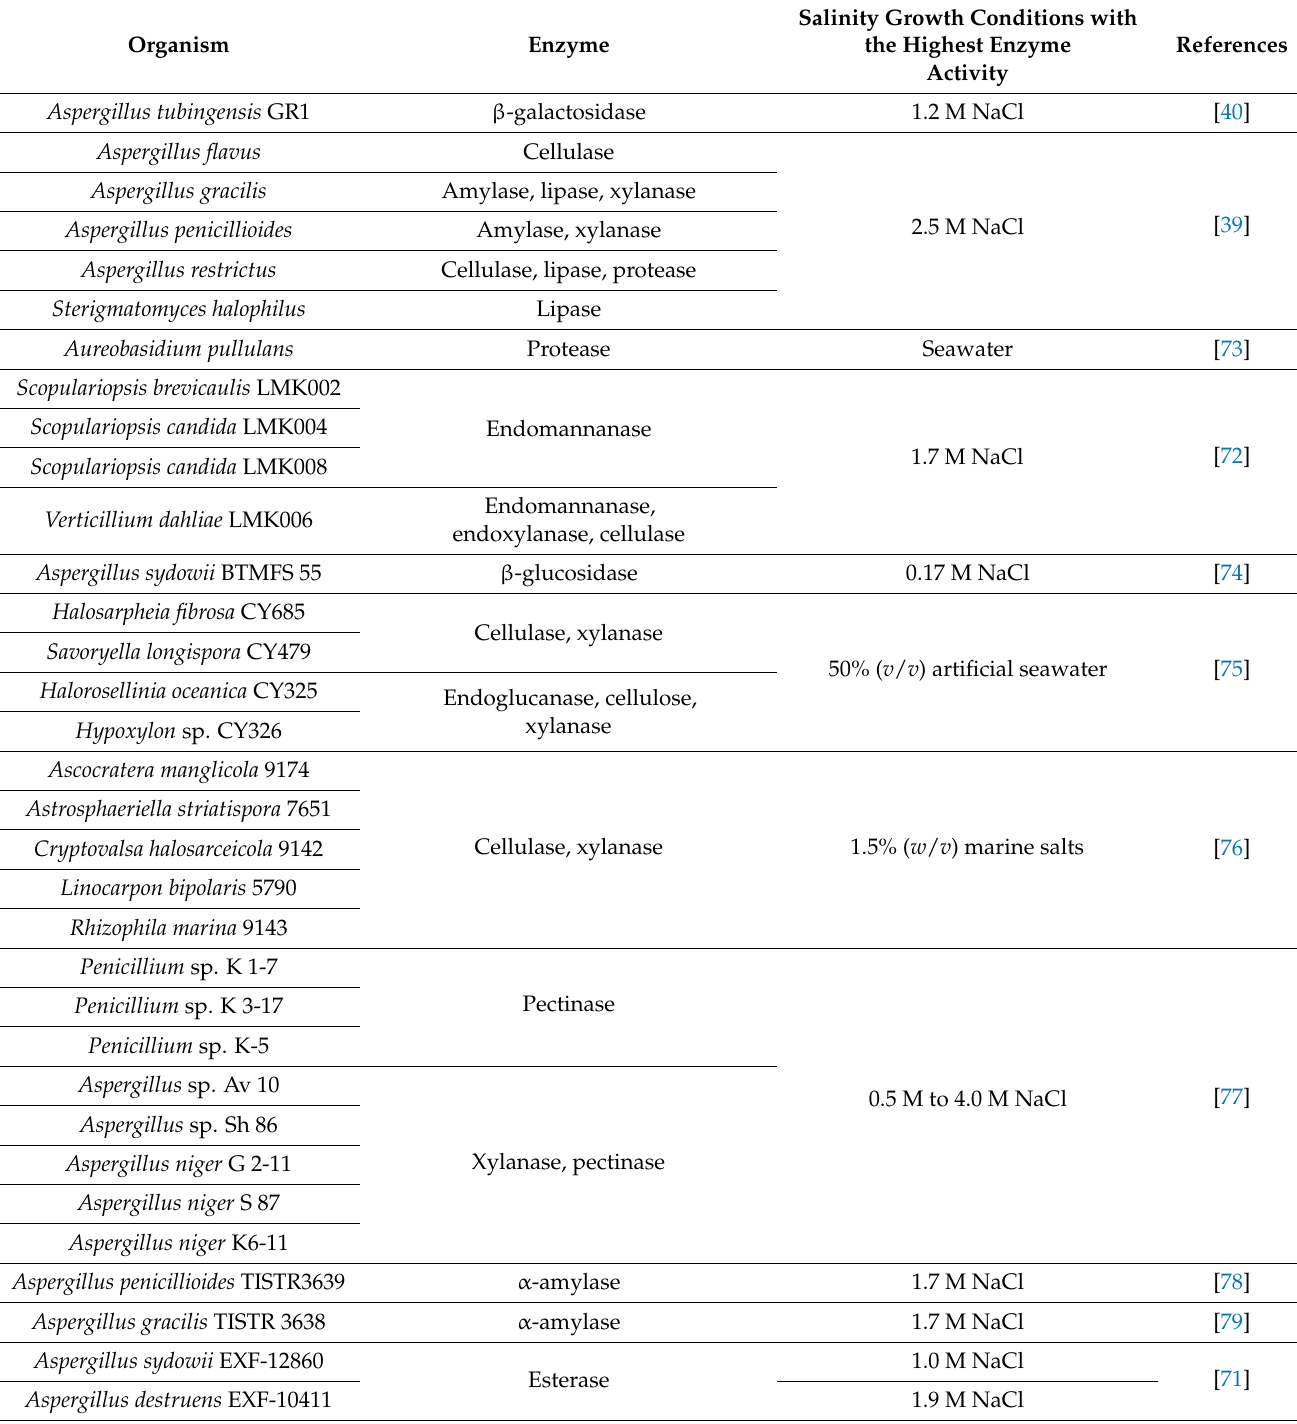
Table 1. Hydrolases produced by halophilic filamentous